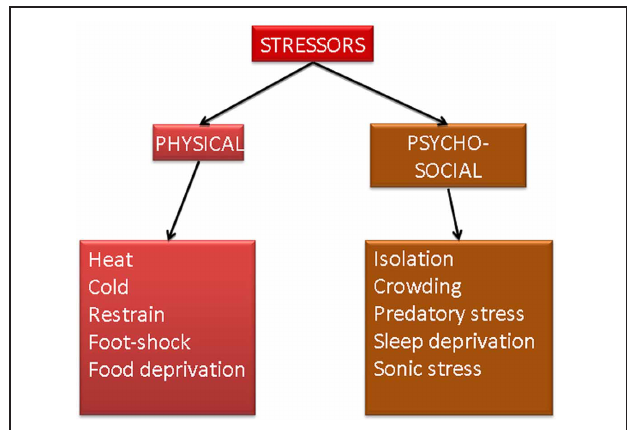
on the auditory system with special focus on tinnitus. In addition, we will attempt to transfer some of the in vitro knowledge into a clinical practice.